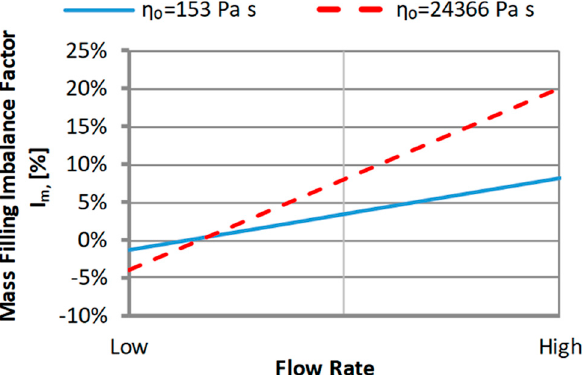
Figure 11. An effect of the zero shear viscosity η 0 on the mass filling imbalance factor I m at various injection rates (Low = 5 cm 3 /s, High = 500 cm 3 /s).